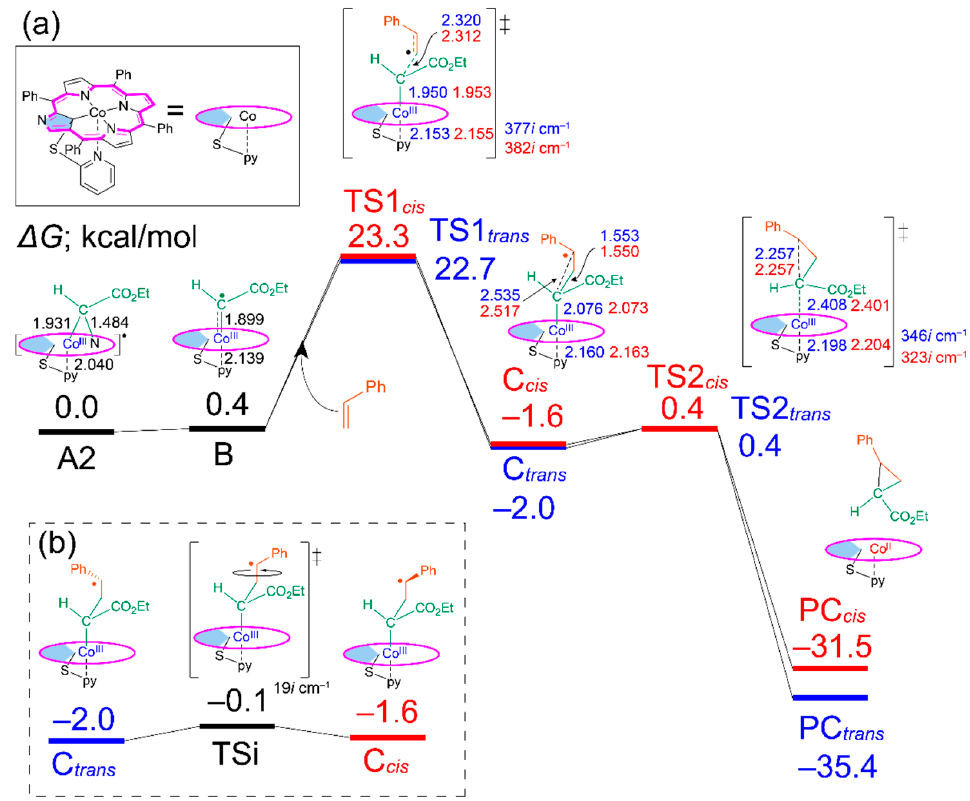
Figure 2. ( a ) Energy profile for cyclopropanation reaction catalyzed by Co(NCTPPSpy) . ( b ) Inter- conversion between C trans and C cis . The relative Gibbs free energies are shown to A2 in kcal/mol. Bond length (Å), Blue: trans route, Red: cis route.